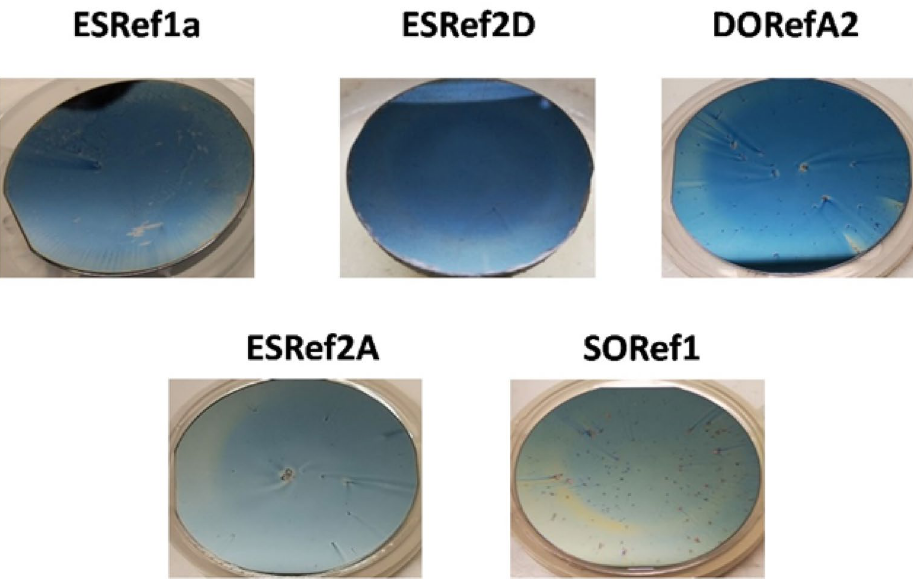
Figure 2. Optical images of reflectin thin-films following fabrication by spin coating 1% w/w reflectin in HFIP onto a clean Si wafer. Camera images were taken following drying. DORefA2/BSA multilayer films were fabricated by spin coating reflectin and BSA